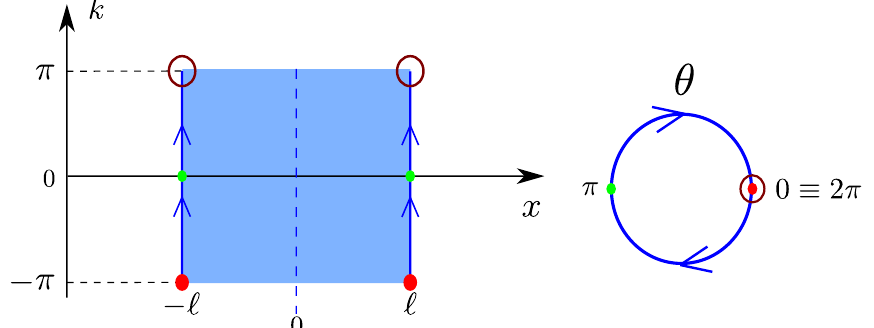
Figure 5: Parametrization of the initial Fermi contour with the coordinate θ along the unit circle. Notice that the horizontal branches of the contour do not contain propa- gating modes and therefore are not needed for the description of the entanglement